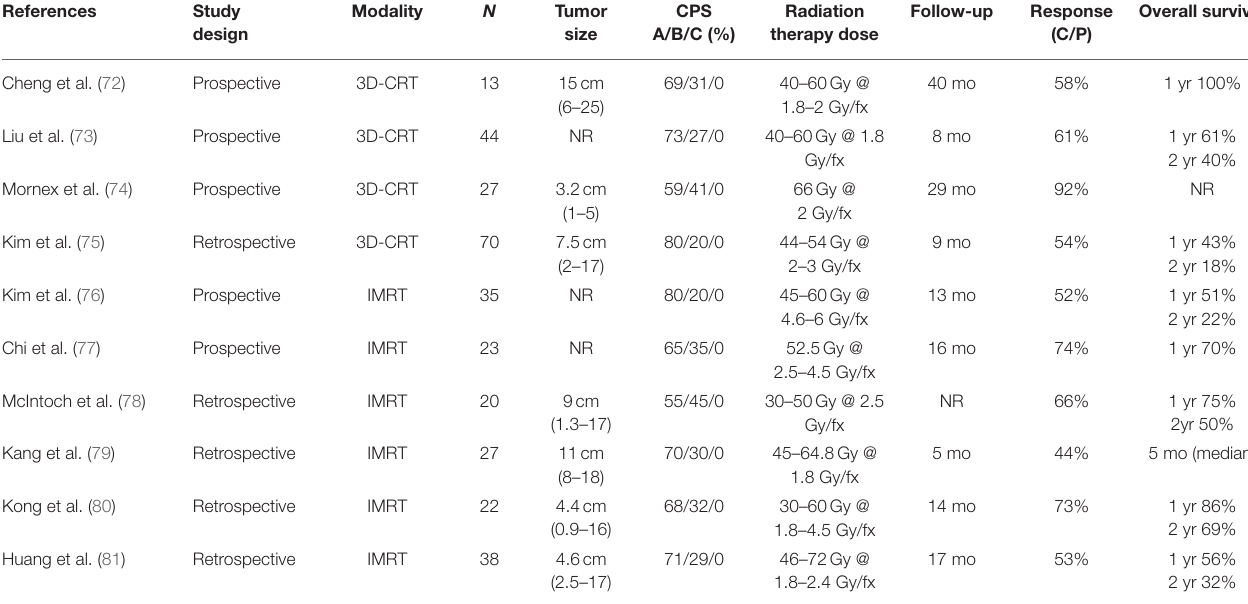
TABLE 4 | Studies of 3D-CRT and IMRT for hepatocellular